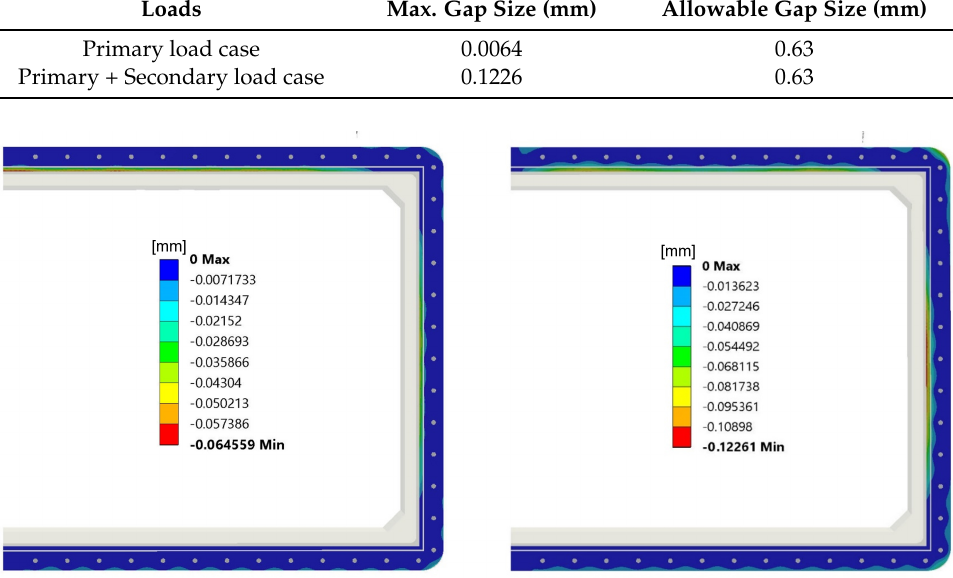
Figure 6. Gap sizes along the base of the TLIC door. Left : resulting gap in case of deadweight + vacuum + lithium pipe pressure loads applied; right : resulting gap in case of normal operation.